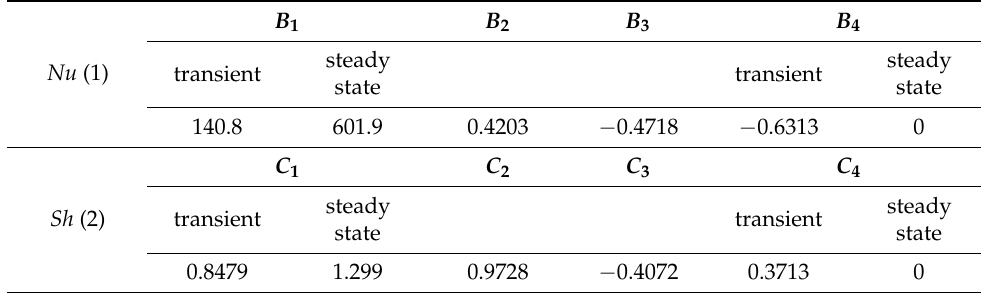
Table 1. The scope of validity of Formulas (1) and (2) included the following ranges of 1.8 ≤ Sc ≤ 5.8. Table 1. Values of the Bi and Ci coefficients in Equations (1) and (2)